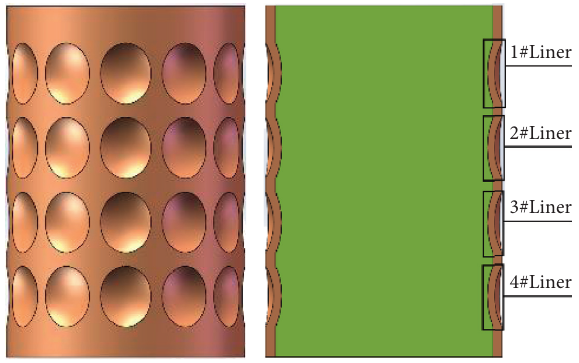
Figure 1: MEFP warhead